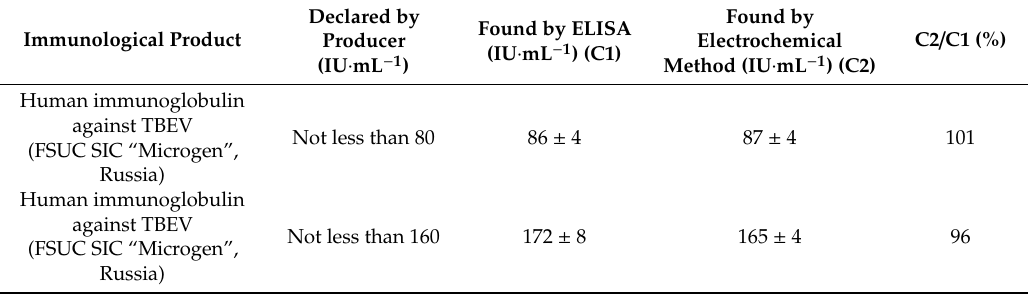
Table 2. Comparative results of measuring concentrations of immunoglobulins against TBEV in immunological products using existing ELISA and the developed electrochemical method ( n = 5, P =